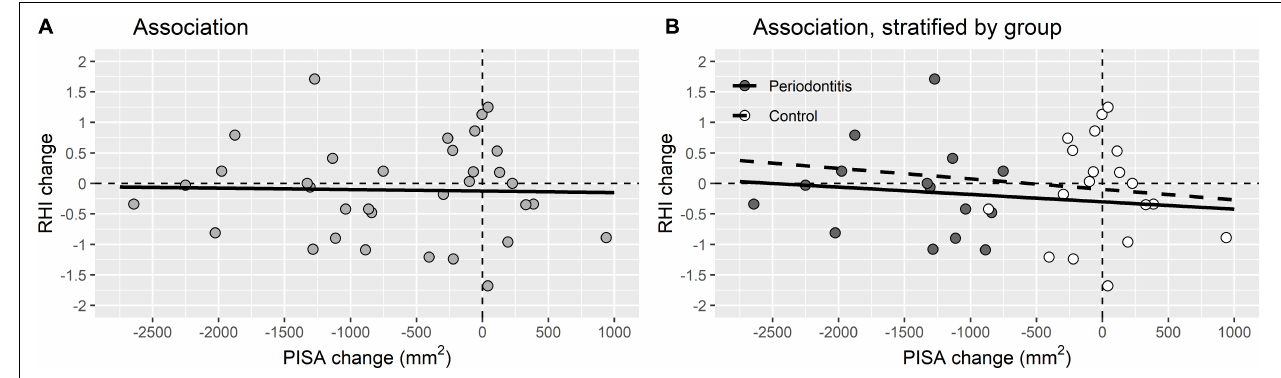
FIGURE 3 | Association between periodontal improvement and endothelial function. (A) Association between PISA change and RHI change for the total study population ( R 2 linear = 6.549E-4). (B) Association between PISA change and RHI change stratified by periodontitis patients ( R 2 linear = 0.008) and control group ( R 2 linear = 0.006) (B)